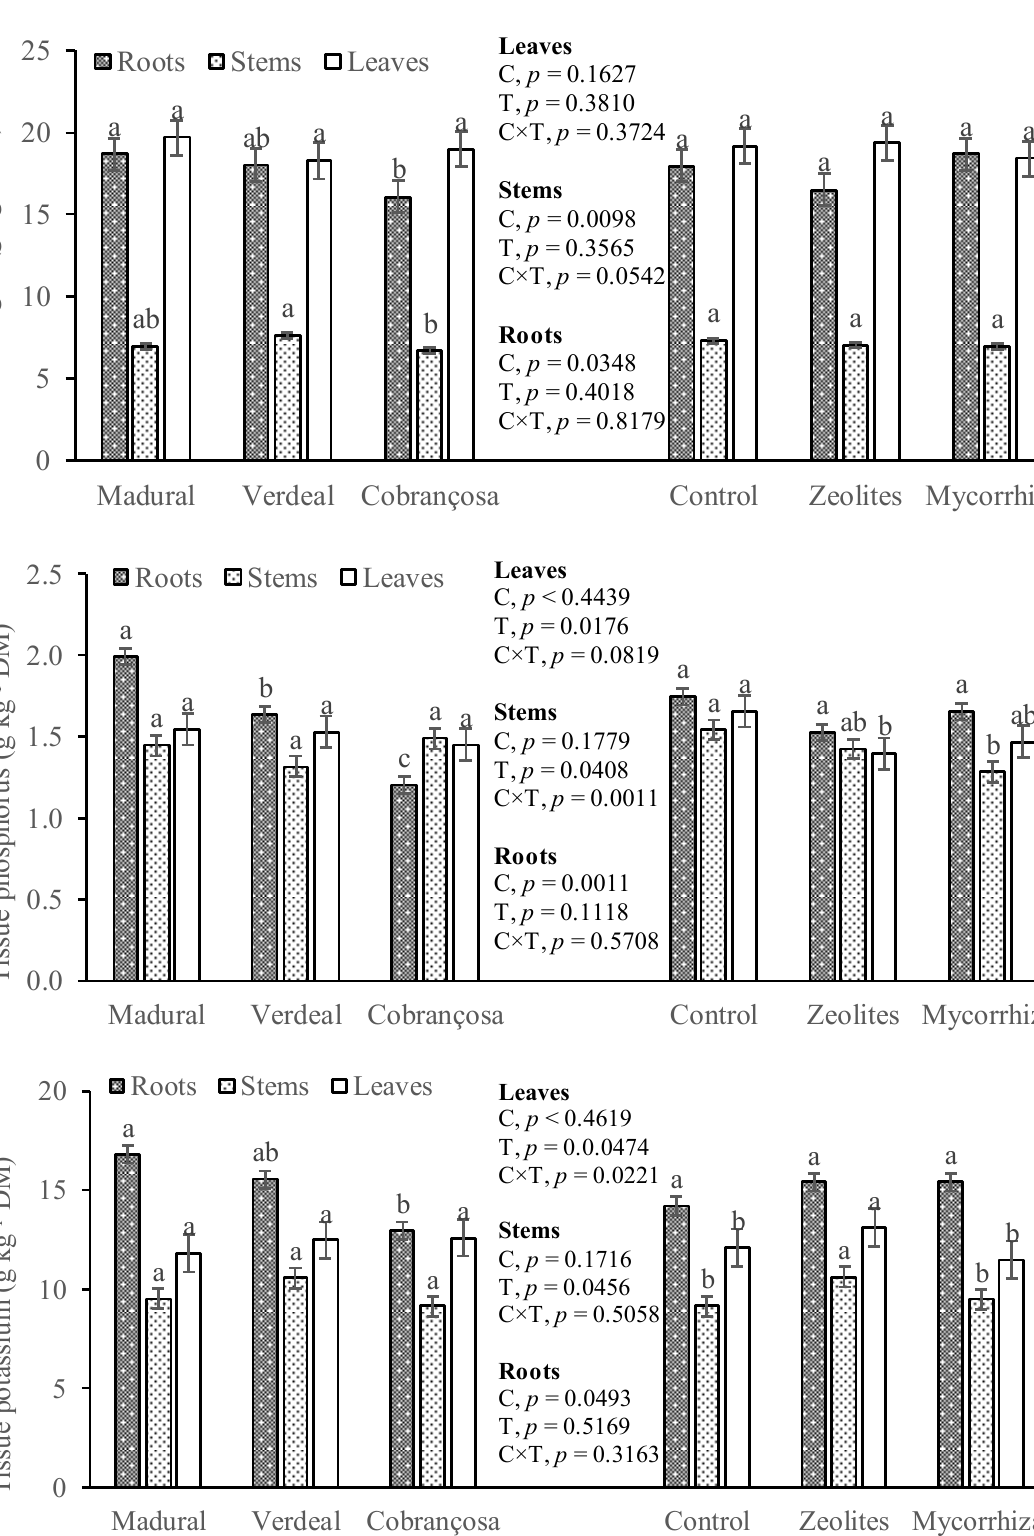
Figure 3. Tissue nutrient concentration in the factorial design of cultivars × soil treatments. After ANOVA examination ( p , Prob. > F), to each experimental factor (cultivars (C) or soil treatments (T)), and within each plant part; means ( n = 6) followed by the same letter are not statistically different by Tukey HSD test ( α = 0.05). Vertical bars are the standard errors.